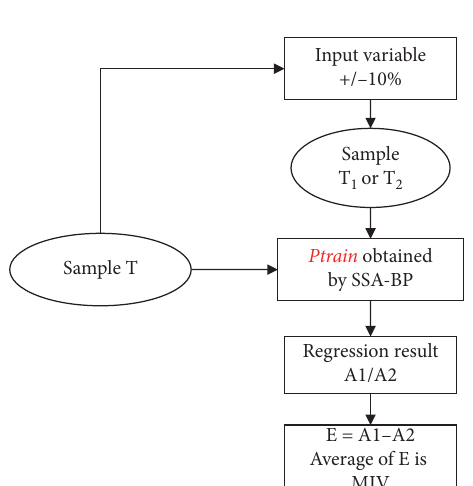
Figure 3: Flow chart of the MIV